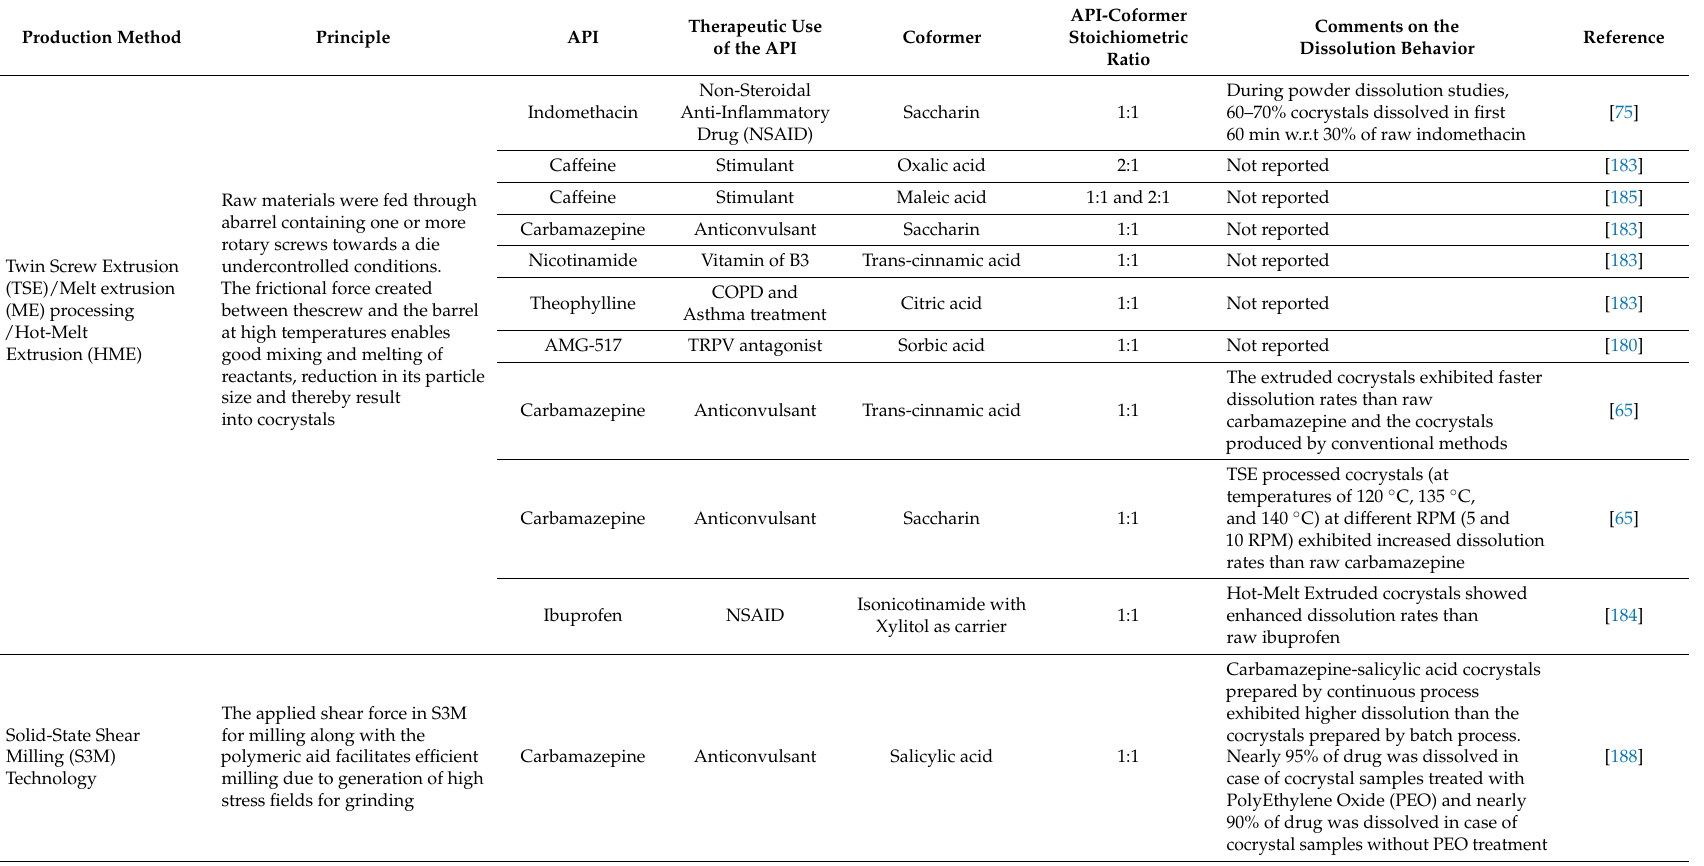
Table 9. Summary of reports available in literature on continuous production of pharmaceutical